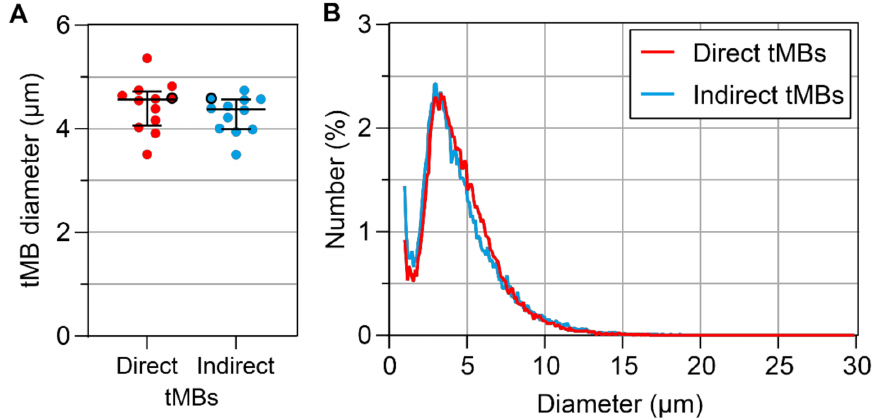
Figure 1. ( A ) Number weighted mean diameter ( µ m) of direct and indirect targeted microbubbles (tMBs). Each circle represents one sample of targeted microbubbles ( N = 12) for each experimental day, with the median and interquartile range (IQR) overlaid in black. The size distribution of circles with a black border is shown in ( B ): number weighted size distribution of direct (red) and indirect (blue) targeted